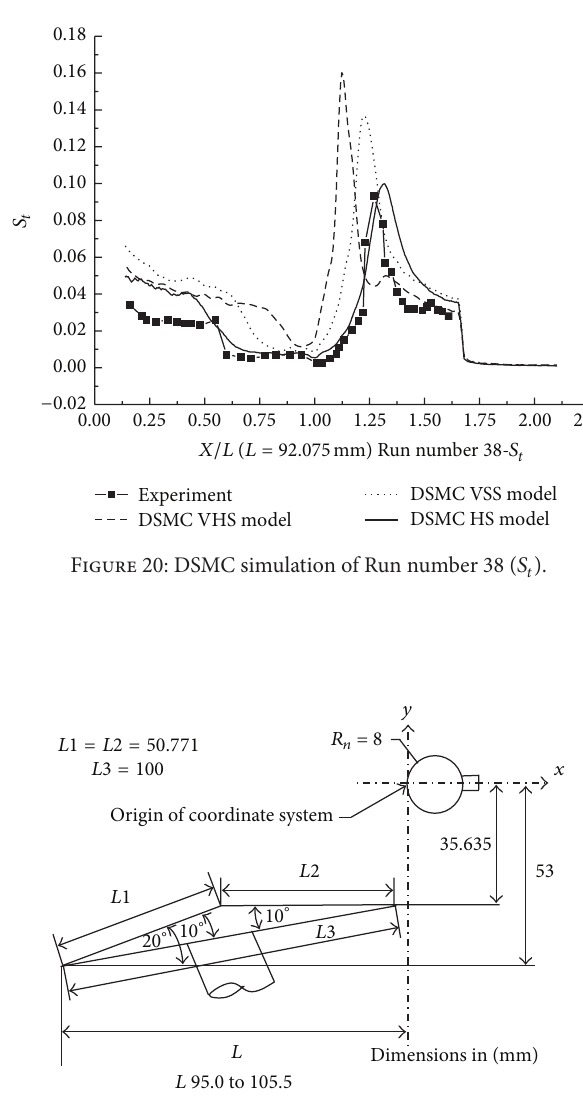
Figure 21: Configuration of Edney’s Type IV shock